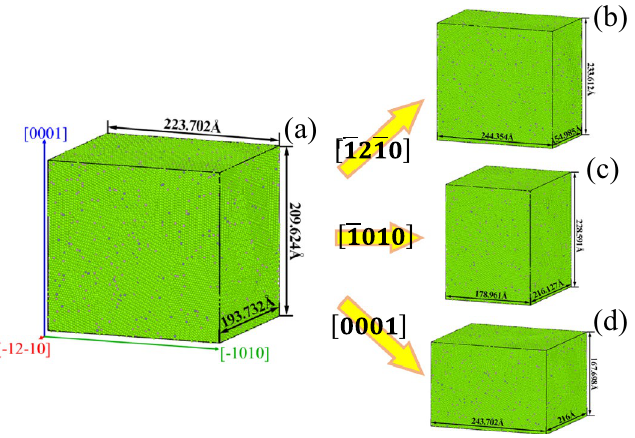
Figure 4. Compression